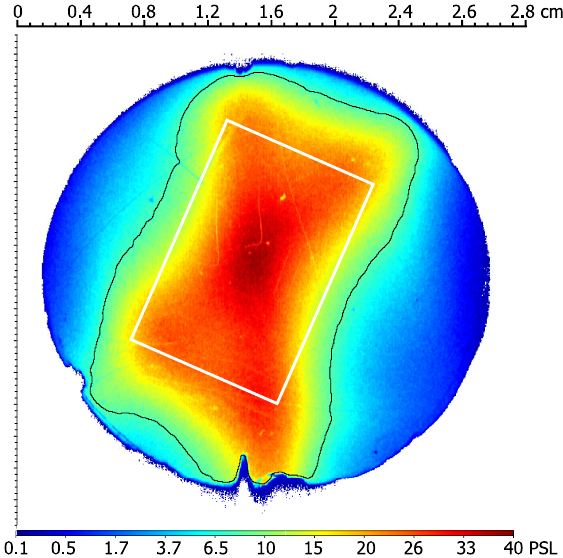
FIG. 8. Transverse profile of the proton beam dose deposition at the transport line output, recorded on an imaging plate with 28 mm diameter. The IP was placed 1 m away from the target, at the biological sample location in air. The isodose curve at 8 PSL (i.e. 20% of the maximum recorded signal) is represented by the black line, and the white rectangle marks the area where the biological sample response was studied.